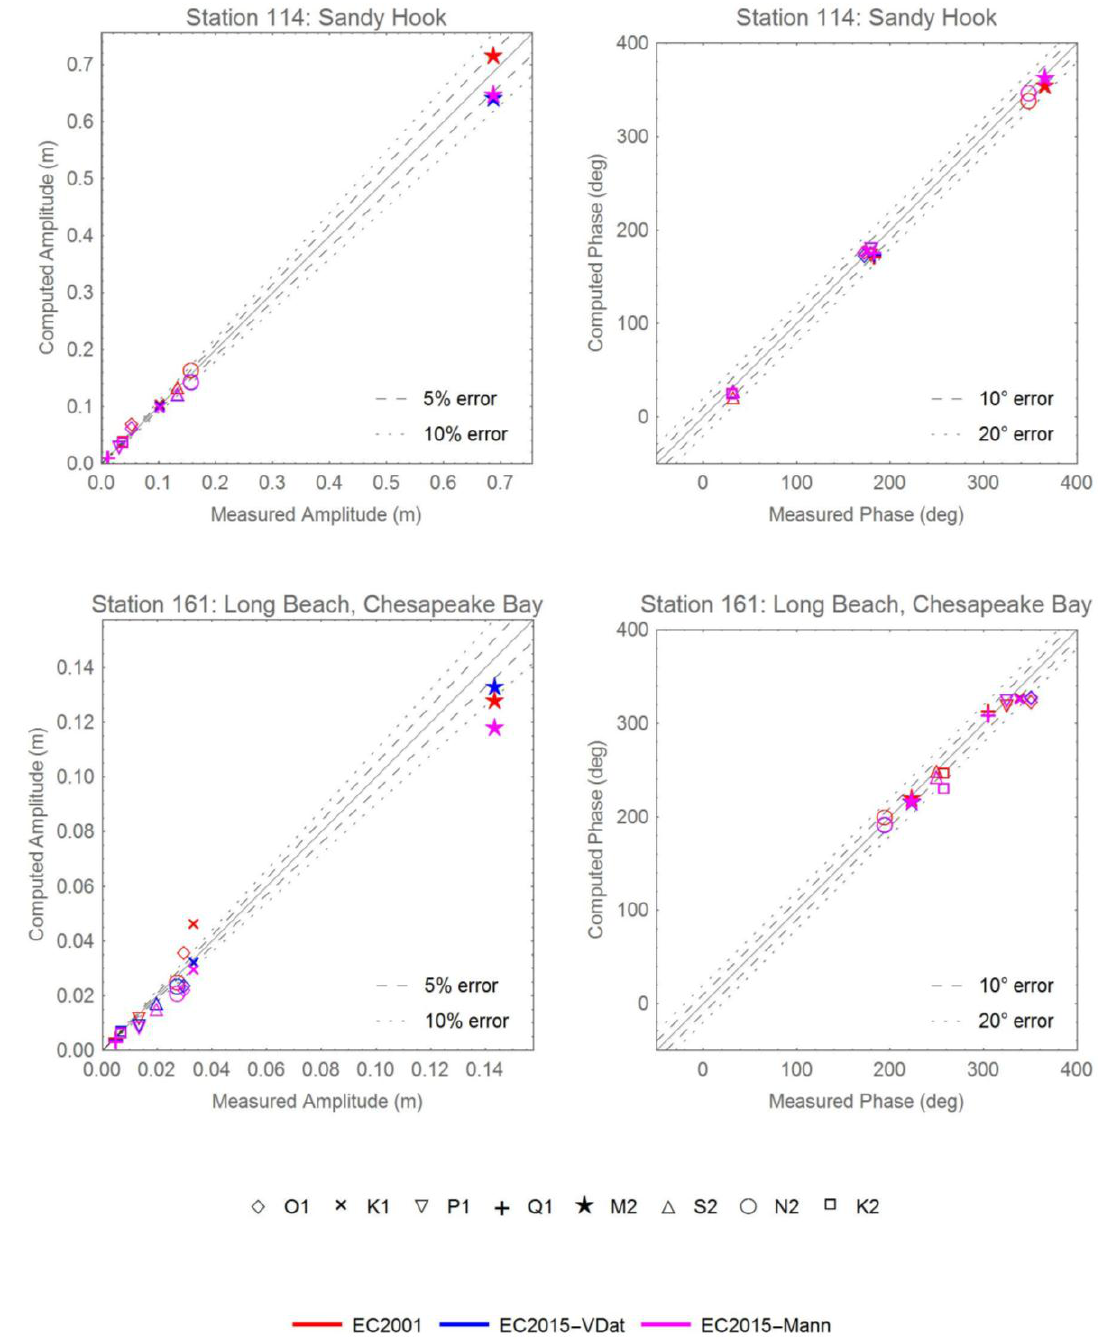
Figure B1. Scatterplots of computed versus measured harmonic data for representative stations along the Atlantic coast.